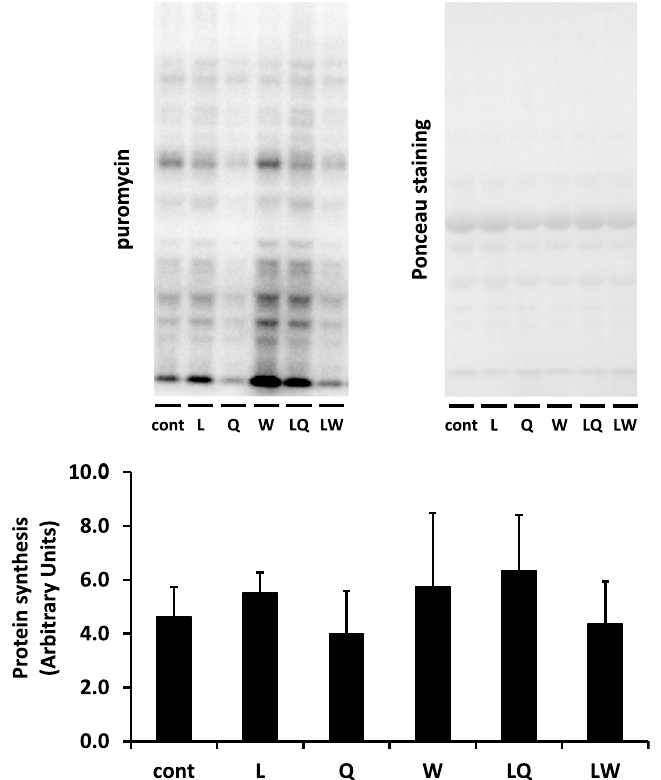
Figure 2. Protein synthesis evaluated by detecting puromycin-labeled peptides in the gastrocnemius muscle of mice administered 0.2% xanthan gum solution (Cont), leucine (L), glutamine (Q), tryptophan (W), leucine + glutamine (LQ), or leucine + tryptophan (LW) with gavage after 24 h fasting. Puromycin is incorporated into the nascent peptide chain; hence, quantification of puromycin incorporation was performed by measuring the density of each lane. Ponceau S staining was performed to verify equal loading of proteins. Densitometry results are expressed as the mean ± SD (n = 5). Mean values without letters are not significantly different among groups (P > 0.05). The original blots are presented in Supplementary Fig.